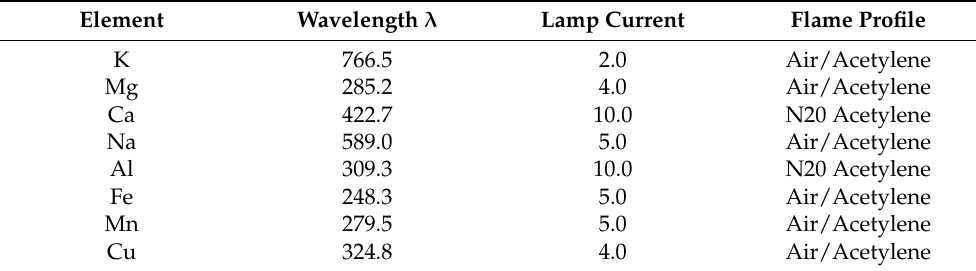
Table 1. Wavelength, lamp current, and flame profile used for elemental analysis of vermicompost tea